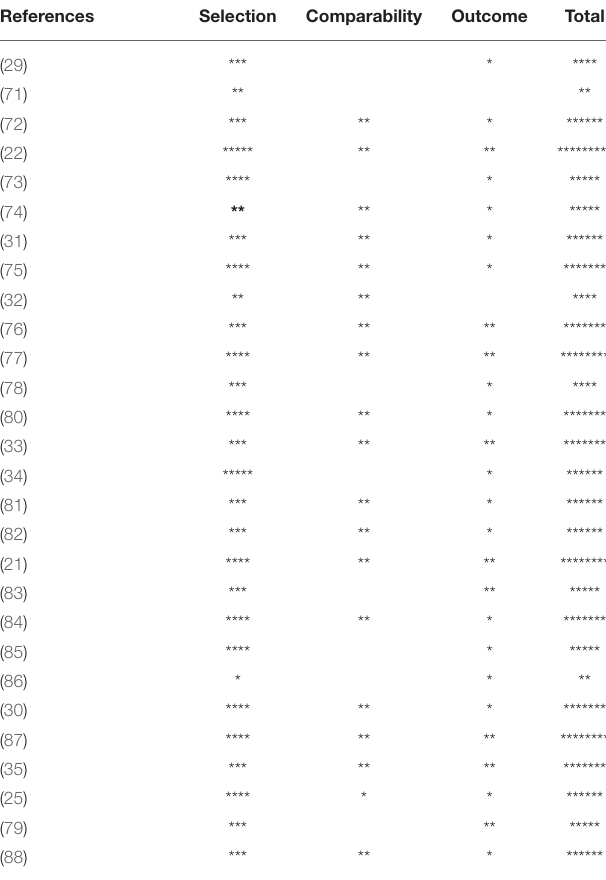
TABLE 2 | The results of quality/risk of bias assessment based on the Newcastle-Ottawa